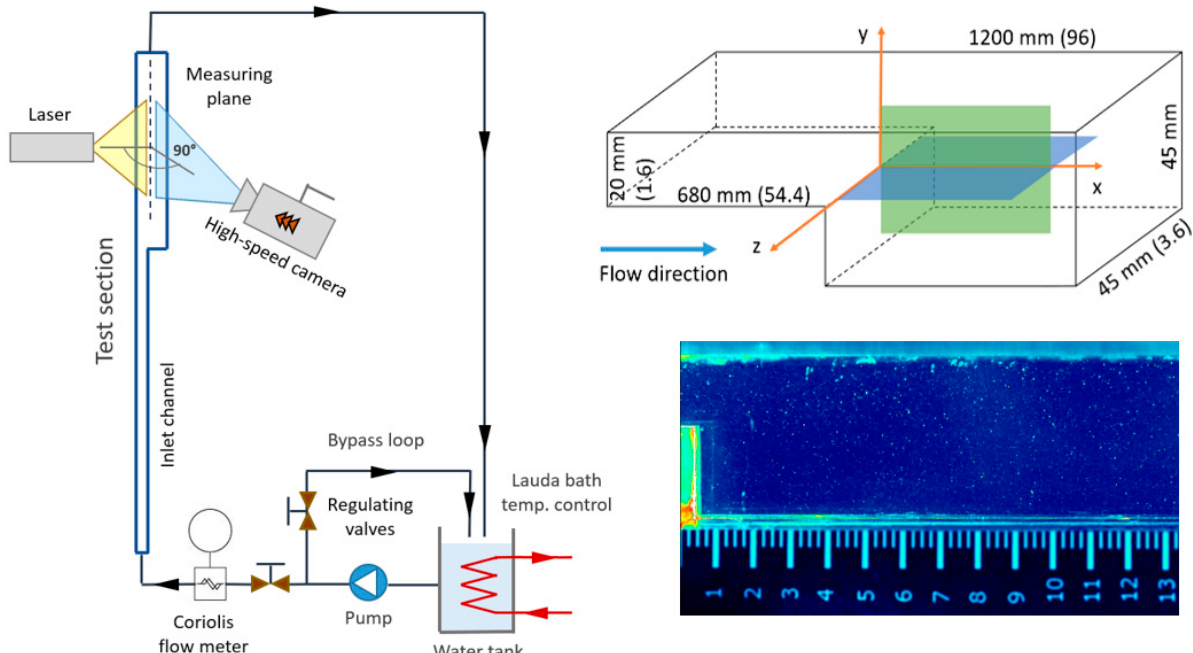
Figure 1. Left: Test loop configuration. Top-right: Schematic of the test-section, coordinate system and measurement planes z = 0 (green) and y = 0 (blue). In parentheses: dimensionless lengths. X-length of the measurement planes is around 25 cm. Bottom-right: raw image for PIV analysis in plane z = 0. Table 1. List of measurements in the planes z = const. and in the planes y = const. Each case contains two measurements: one with camera at position at x = 4 cm and another at x = 16 cm. Reynolds numbers are given for each of them.